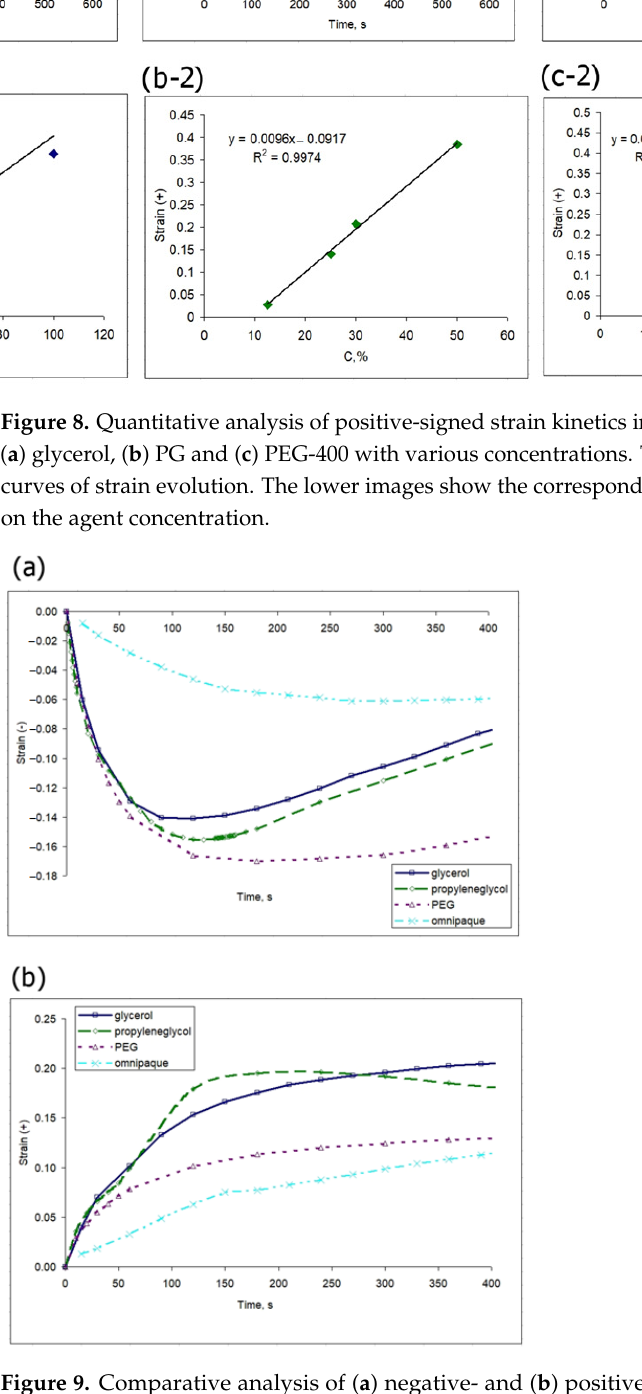
Figure 9. Comparative analysis of ( a ) negative ‐ and ( b ) positive ‐ signed strain kinetics induced in cartilage by the action of glycerol, PG, PEG ‐ 400 and Omnipaque with a concentration of 30% ( v / v ).